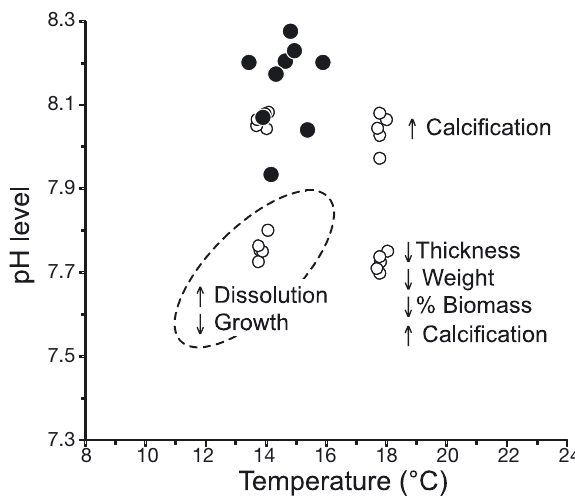
Fig. 7. Graphical summary for the variability of each temper- ature/pH combination in the experimental treatments (open circles); the natural variability in temperature/pH recorded inside Tongoy Bay in December 2014 (black dots) during a field survey, and the environmental range of pH and tem- perature reported for Pt. Lengua de Vaca upwelling area (dashed ellipse, see ‘Discussion’). The significant effects recorded in each shell characteristic of Argopecten purpura- tus are indicated by up or down arrows and presented beside each pH/temperature